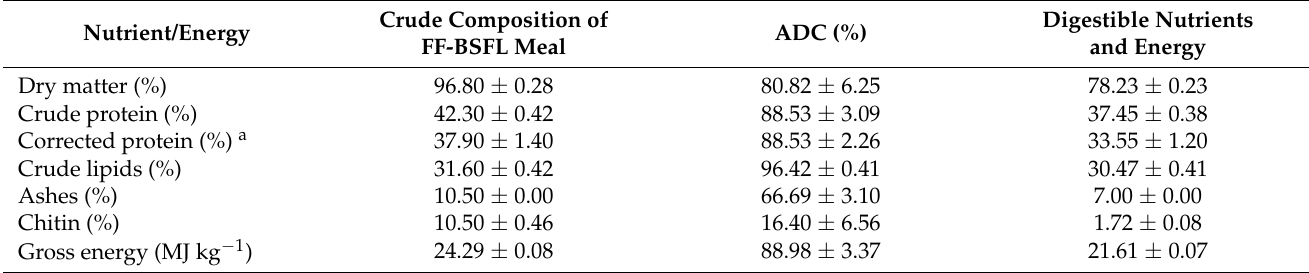
Table 4. Composition, apparent digestibility coefficient (ADC), values of digestible nutrients, and energy of the full-fat black soldier larva meal (FF-BSFL).